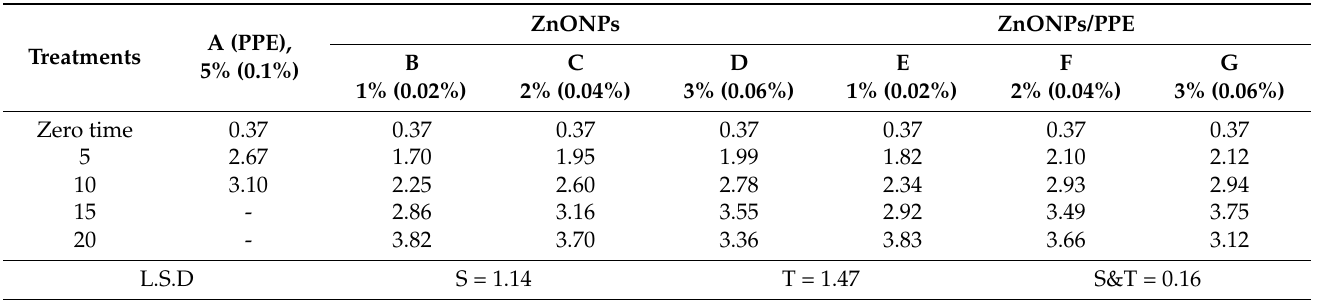
Table 11. Effect of edible film and coatings on total microbial count of manfalouty pomegranate during storage at 2 ◦